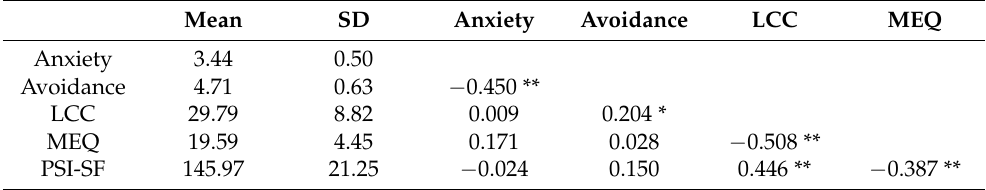
Table 1. Descriptive statistics and Spearman’s correlations between the study’s variables. Mean SD Anxiety Avoidance LCC Anxiety